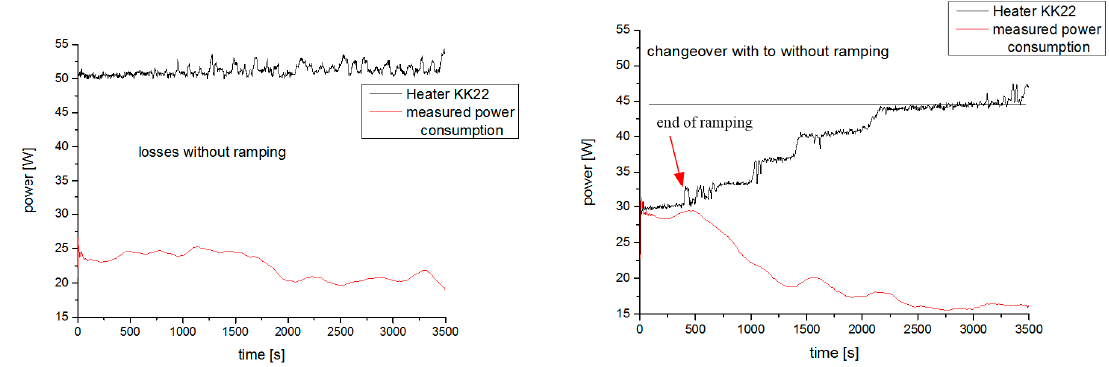
Figure 16. The measured heat losses [W] in the first SIS100 BPL series module, measured at a temperature of 4.5 K for a static condition ( left ) and for a transition from a dynamic load (ramping) of superconducting busbars to a static condition ( right ).